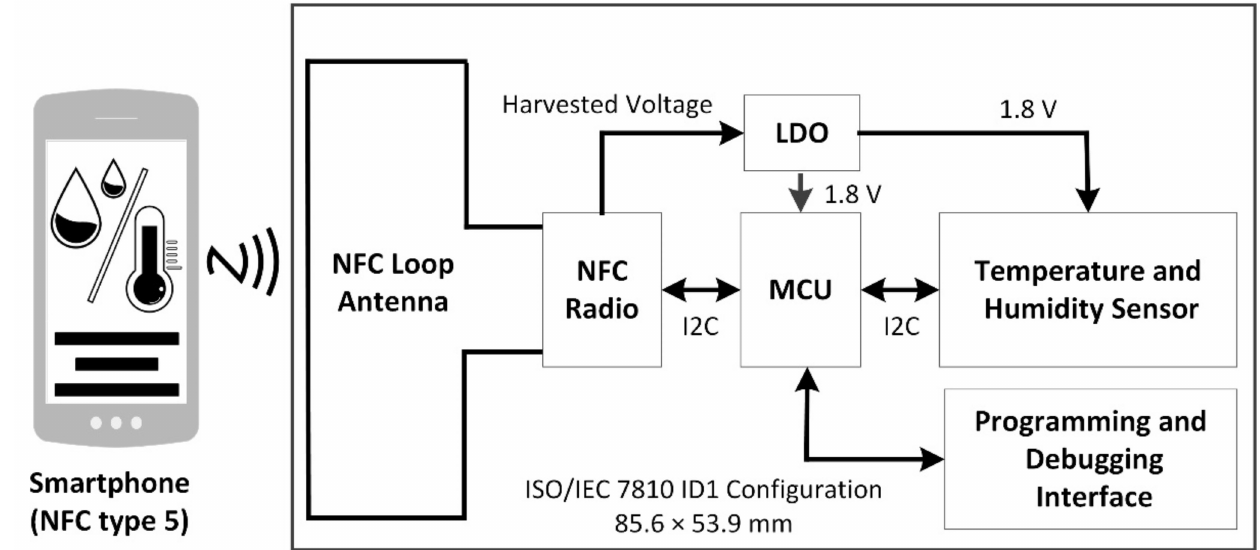
Figure 2. Block diagram of proposed NFC sensor that is powered using a